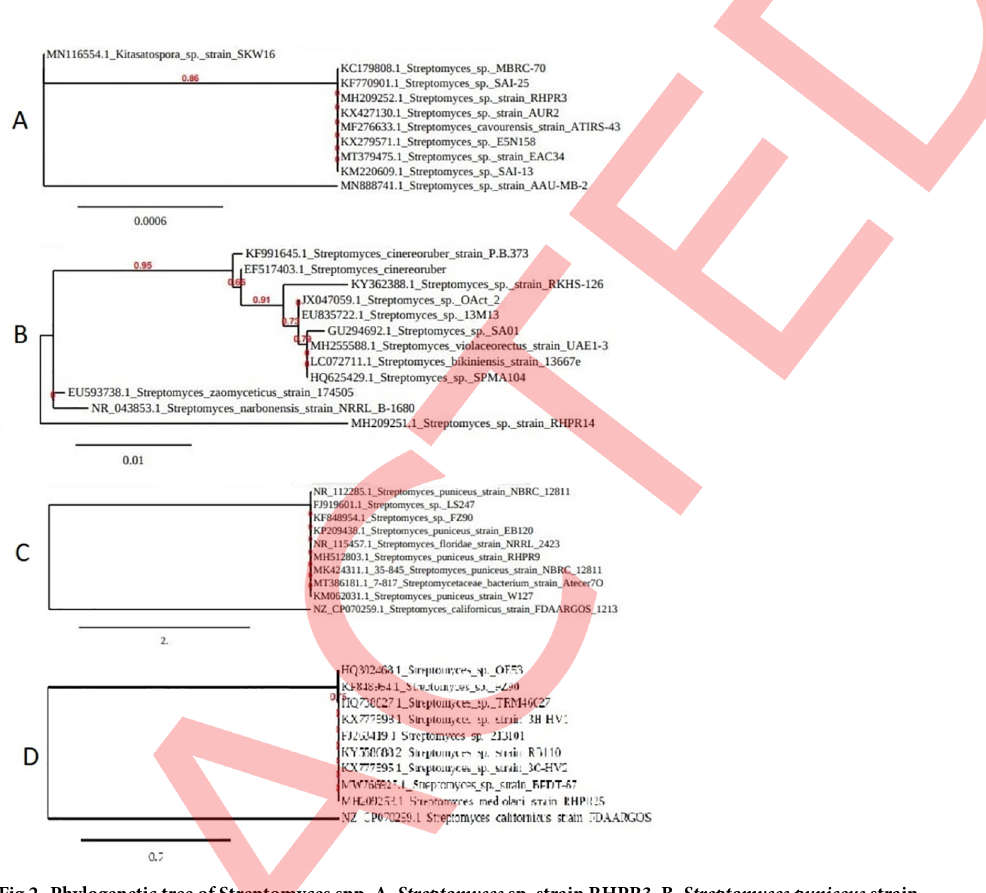
Fig 2. Phylogenetic tree of Streptomyces spp. A. Streptomyces sp. strain RHPR3, B. Streptomyces puniceus strain RHPR9, C. Streptomyces sp. strain RHPR14 and D. Streptomyces mediolani